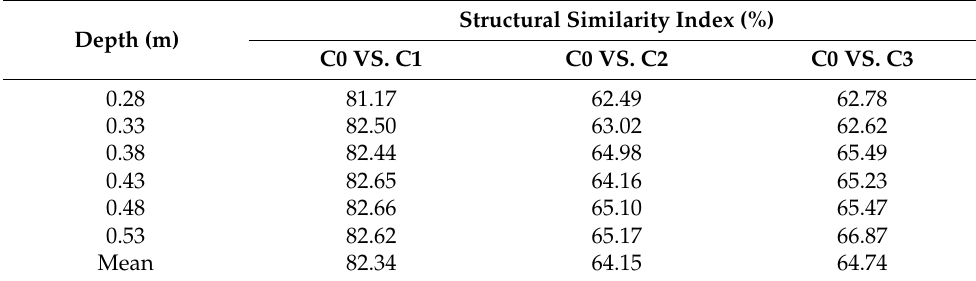
Table 3. Structural similarity index between different datasets at different depth slices.